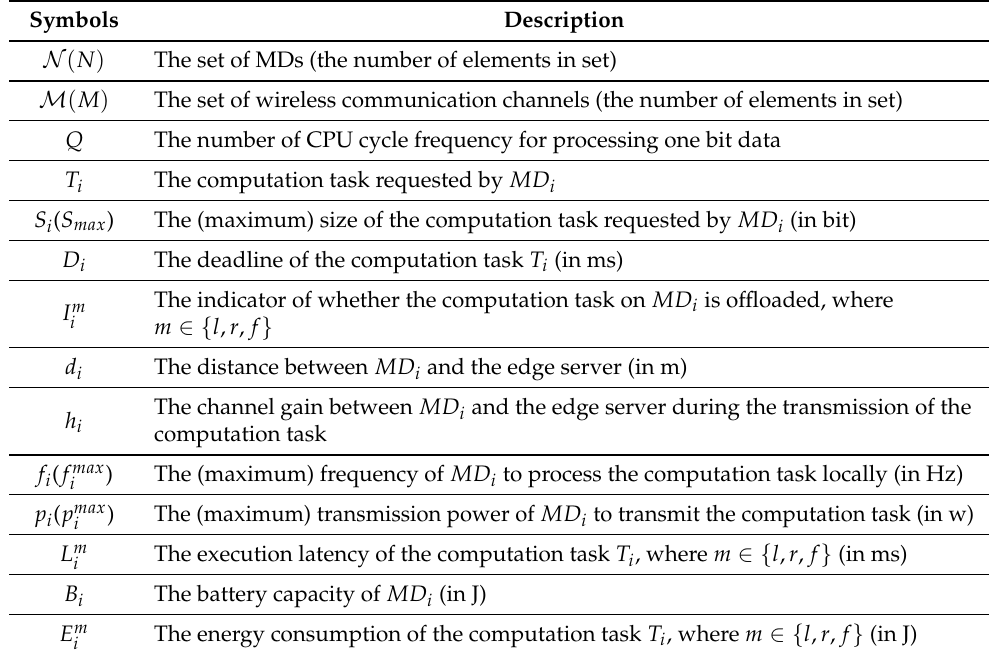
Table 1. Important symbols used in the paper and their